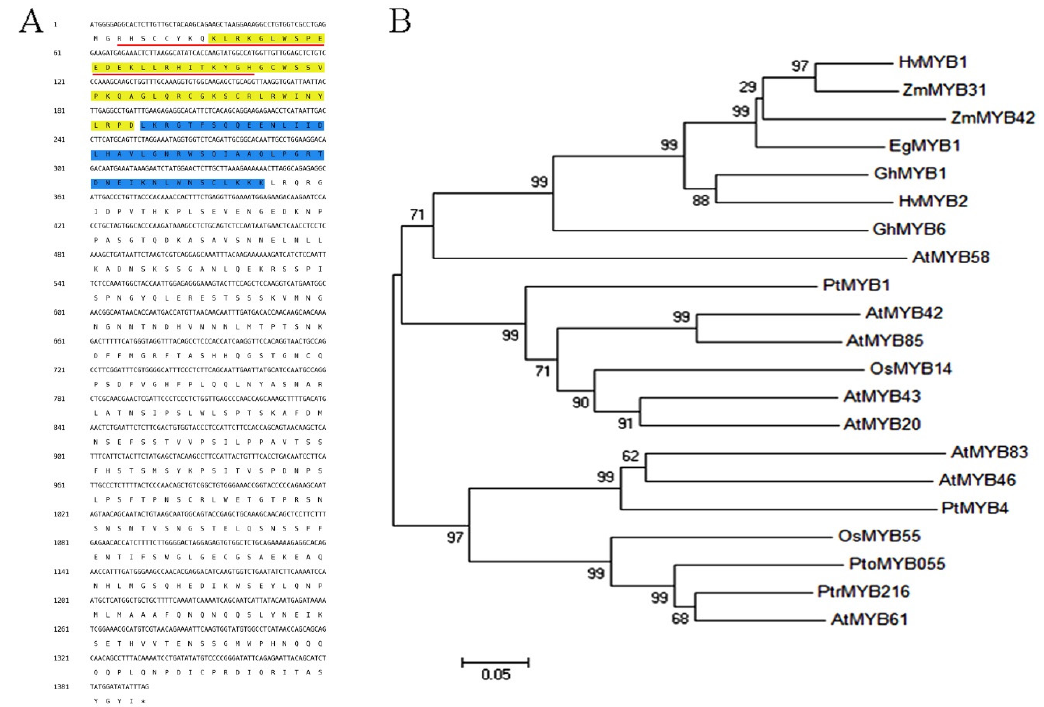
Figure 1. Characterization of the PtoMYB055 protein. ( A ) Amino acid sequence of the coding region of PtoMYB055. The nuclear localization signal is underlined with red line. The R2 MYB domain is highlighted with yellow and the R3 MYB domain was highlighted with blue. ( B ) The phylogenetic relationship between PtoMYB055 and other MYB transcription factors associated with the secondary cell wall was constructed with the neighbor-joining method in MEGA (version 5.1) [35] . Bootstrap values are shown as percentages at the nodes. The GenBank accession numbers of sequences used are given in Section 4.